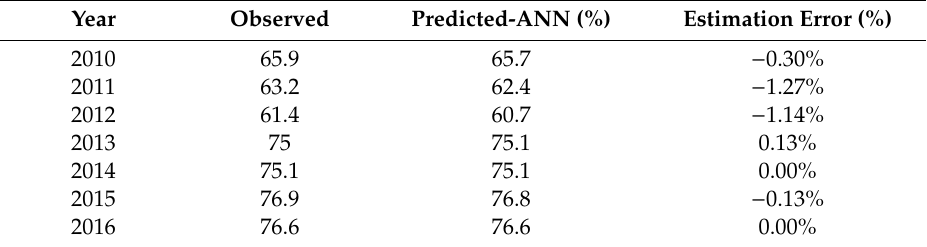
Table 5. Comparison between observed and predicted WER between 2010 and 2016.